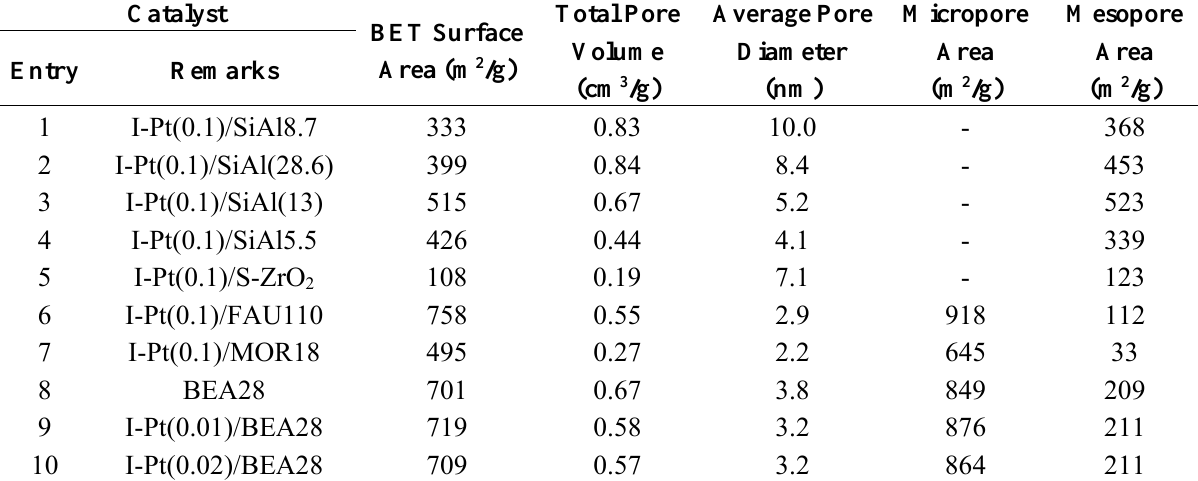
Table 1. Surface area, pore volume, and pore diameter of Pt-loaded